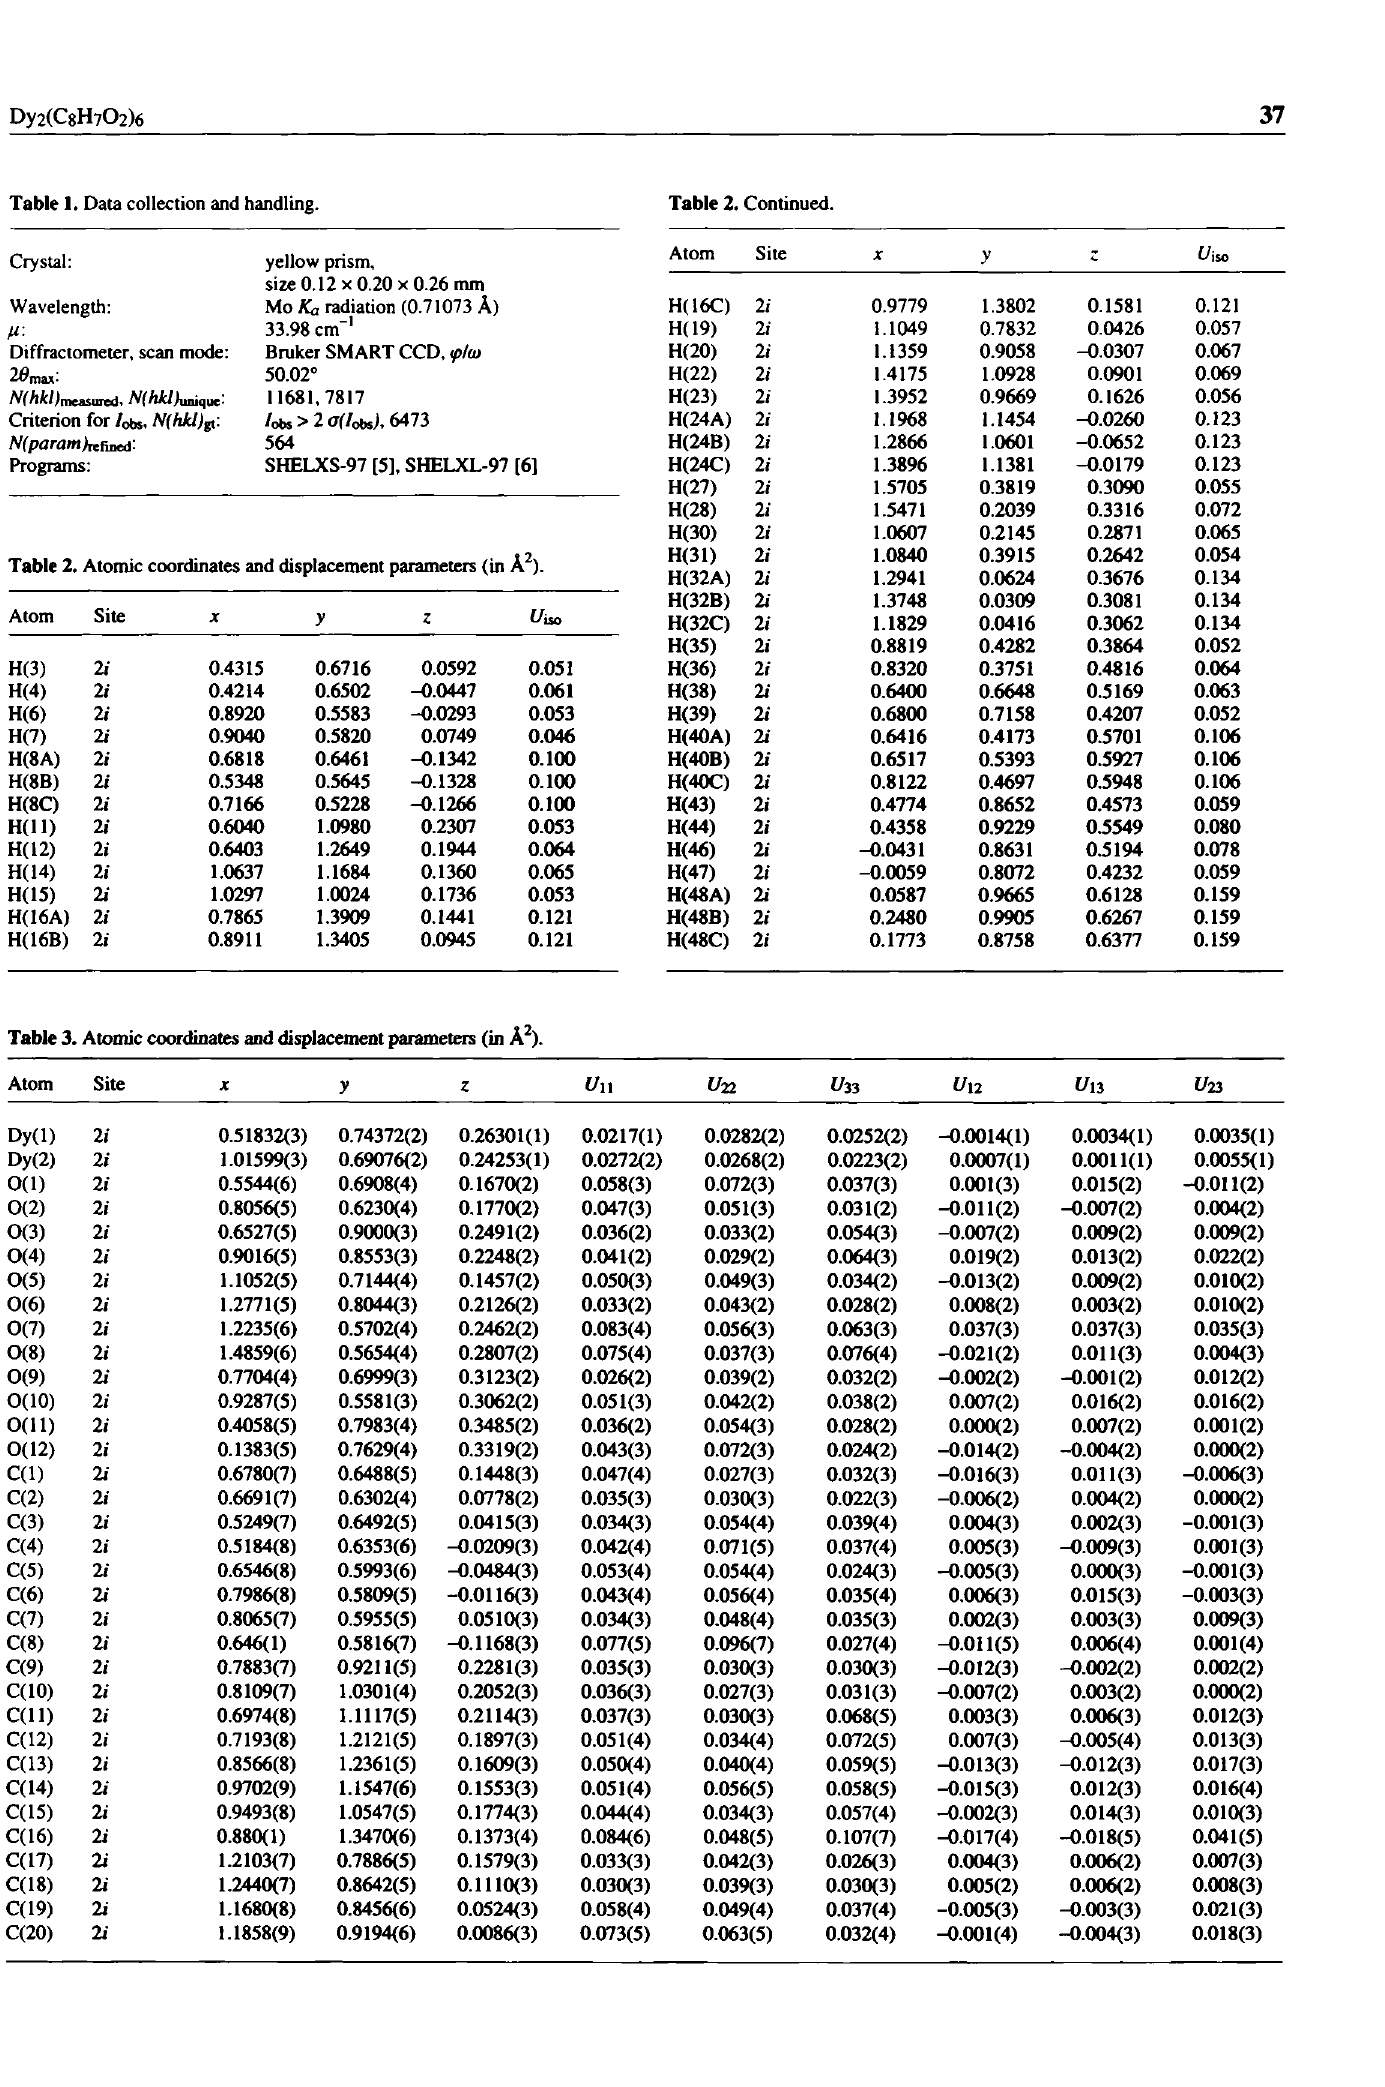
Table 3. Atomic coordinates and displacement parameters (in A 2